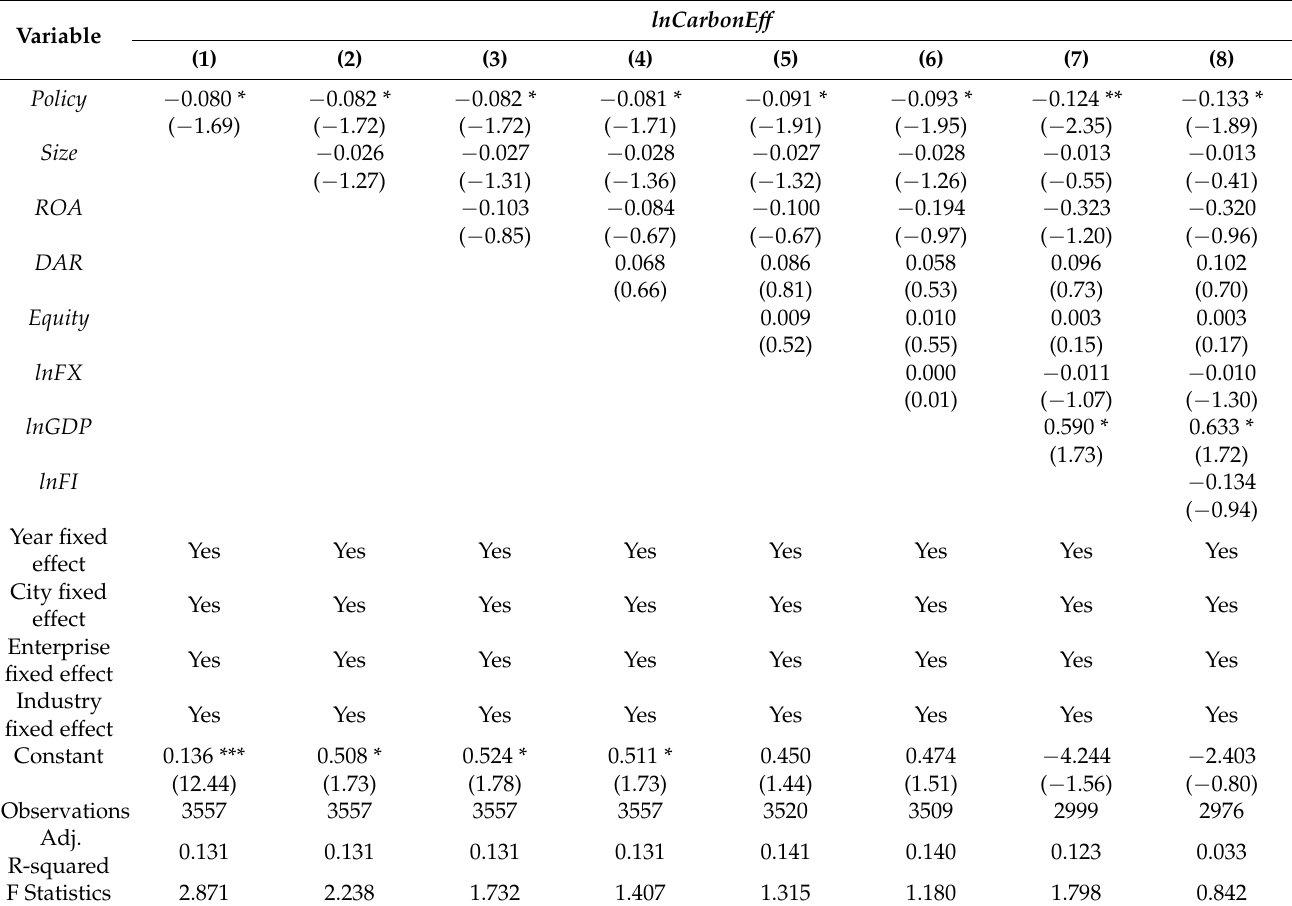
Table 4. Regression results of the PSM-DID